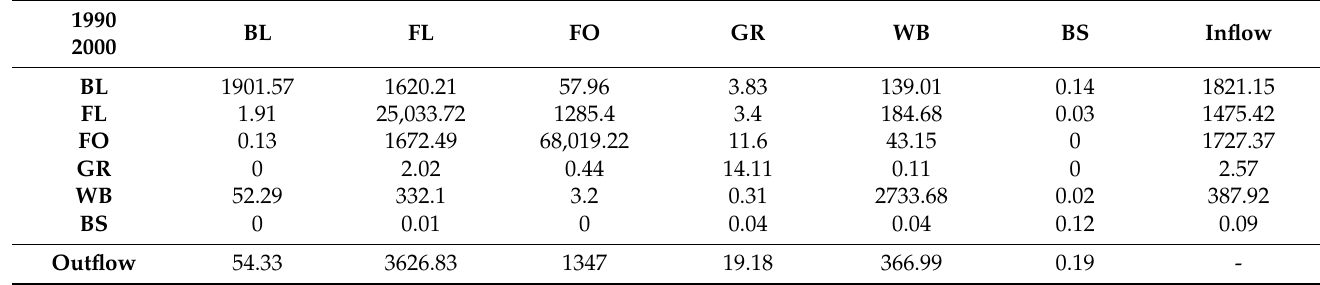
Table 4. Transfer matrix of land use change in Zhejiang Province from 1990 to 2000 (km 2 ).